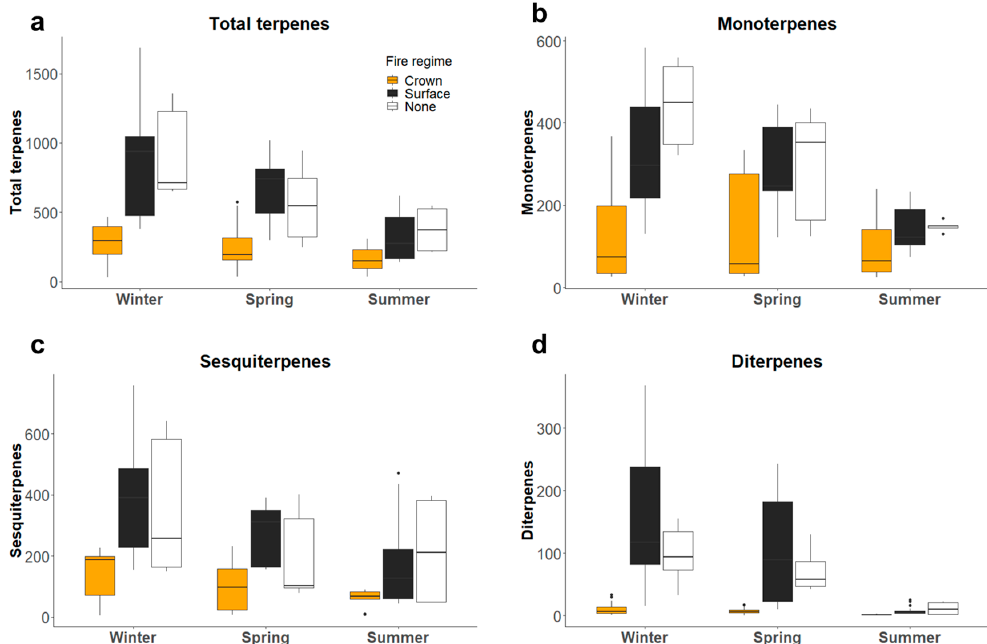
Figure 3. Terpene content of lab-dried pine needles. The terpene content, determined by GC-MS analysis, of lab-dried needles of pine species, grouped by fire regime and season, are shown. Terpene concentration (( a )—total terpenes; ( b )—monoterpenes; ( c )—sesquiterpenes; ( d )—diterpenes) are reported in relative abundance (total peak area relative to α -pinene standard per gram dry weight). The boxes represent the interquartile range, with the median indicated; n = 15 (crown), 15 (surface) and 9 (none), with five species from both crown and surface fire regimes and three non-fire species, for each season.